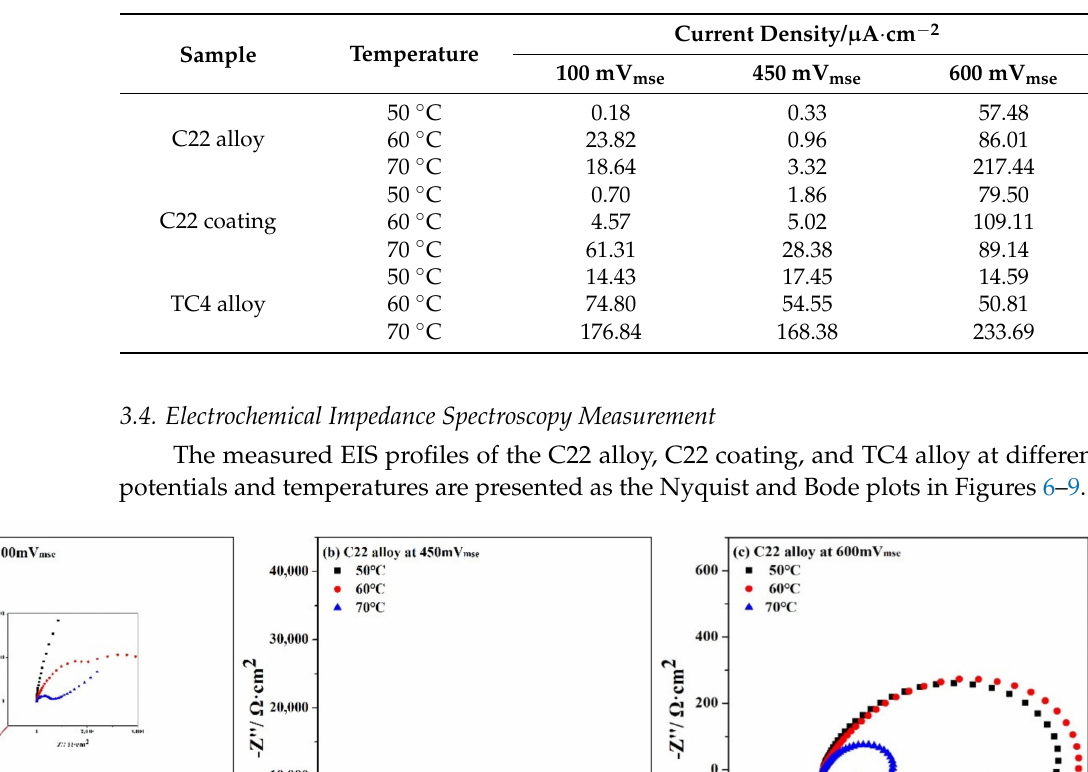
Table 3. The average values of the current density of the C22 alloy, C22 coating and TC4 alloy from potentastic polarization curves for the last 1800 s at different temperatures and potentials.